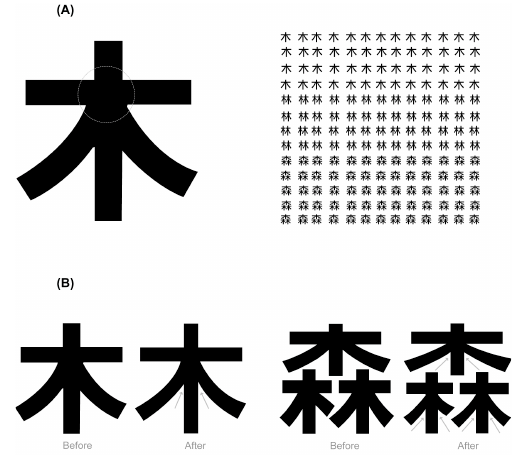
Figure 1. As two or more lines cross, the point of overlap creates an optical point of visual illusion. This area of stroke overlap, or crossings, should be suitably thinned or shrunken to minimize diffusion, as demonstrated by the Chinese character